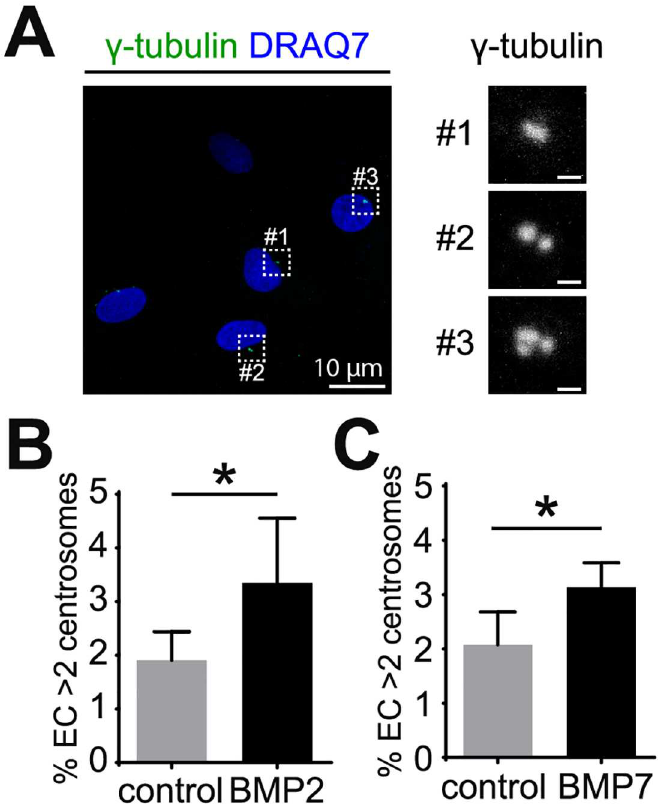
Fig 1. BMP2 and BMP7 induce excesscentrosomes in EC. (A) Representative images of HUVEC with normal(#1 and #2) and over-duplicatedcentrosomes (#3). HUVEC were stained with γ -tubulinfor centrosomes (green)and DRAQ7 for nuclei (blue). (B, C) Frequency of excess centrosomesin HUVEC after treatment with 200 ng/ml BMP2 (B) or BMP7 (C) for 4 days. Error bars, standarddeviationfrom mean. Statistics: two-tailed unpairedStudent’s t-test. * , p (cid:20) 0.05. Scale bars: 1 μ m unless